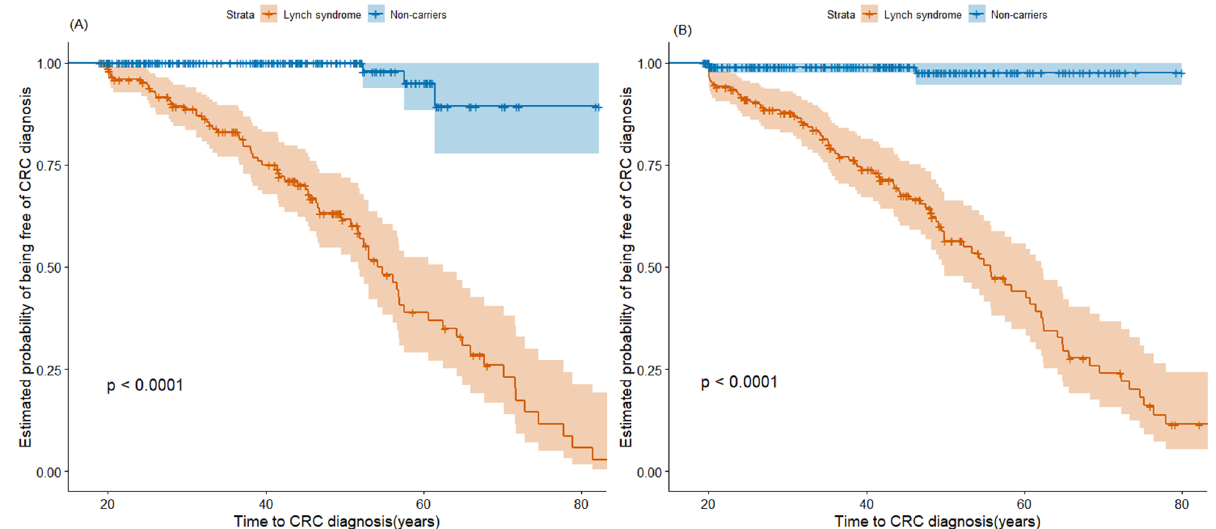
Figure 1. Kaplan–Meier survival of patients with Lynch syndrome compared to non-mutation carriers. ( A ) Male patients with Lynch syndrome were associated with an early onset of CRC compared to male non- mutation carriers. ( B ) Female patients with Lynch syndrome were associated with an early onset of CRC compared to the female non-mutation carrier. The figure was produced using the survival package and ggsurvplot from the survminer package in R software (version 3.6.2, R Core Team 2019, https:// www.r- proje ct. org/).